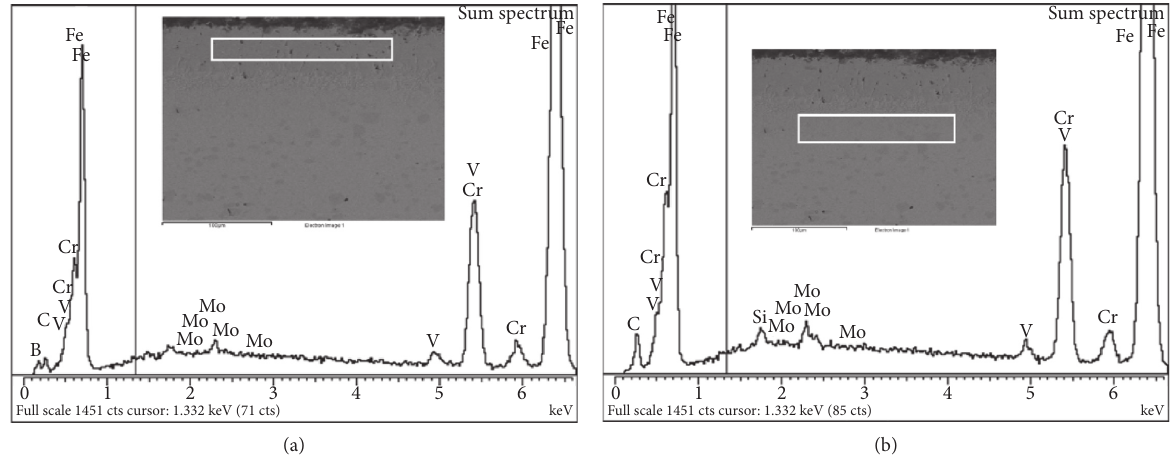
Figure 6: SEM micrograph and EDS patterns obtained in the (a) Fe